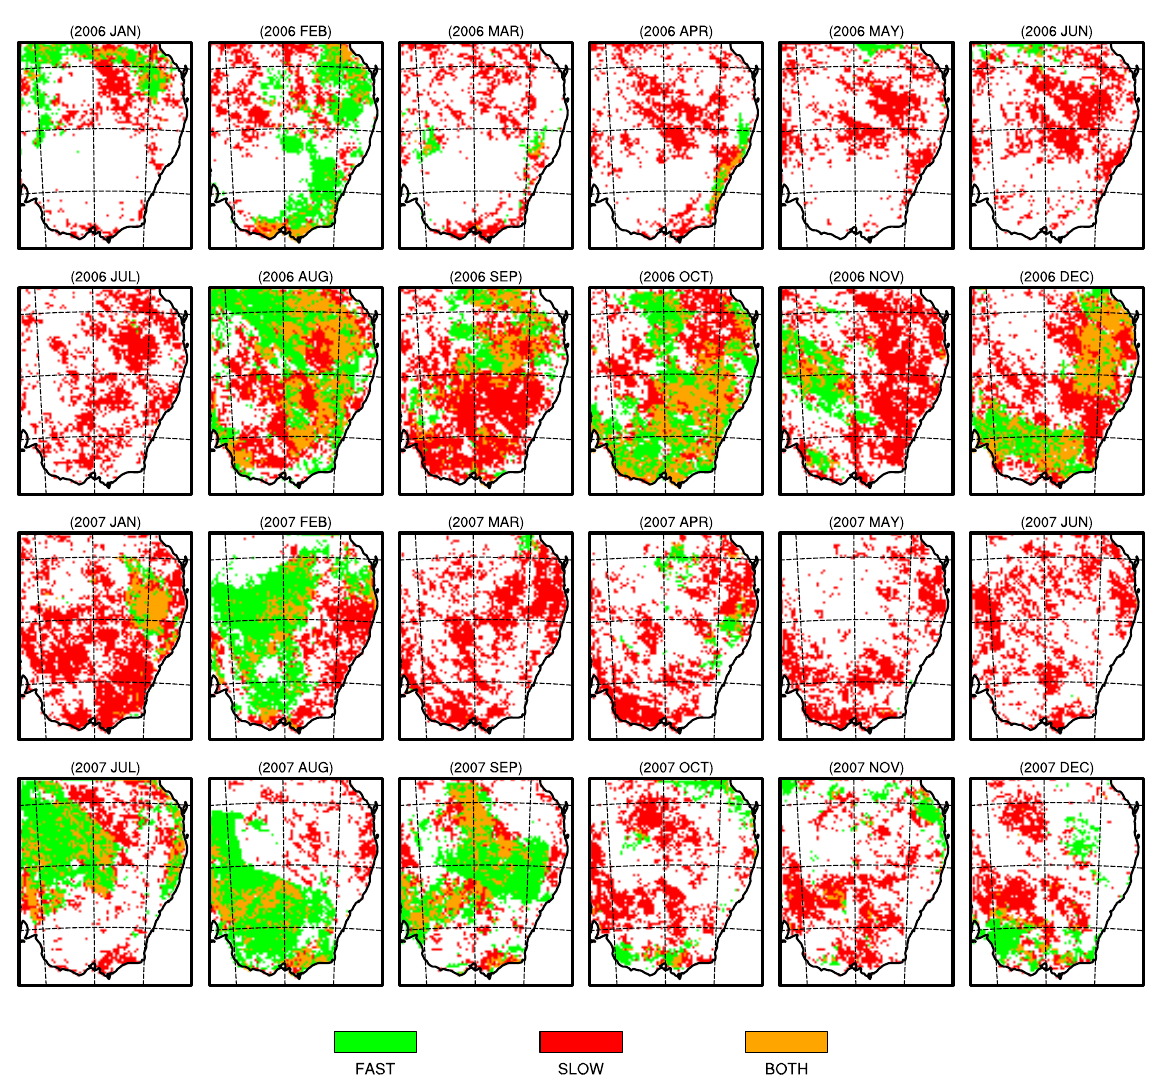
Figure 14. Distribution of the physical (fast) and biological (slow) mechanisms that exist in monthly and annual variations in the WRF_BOTH simulation in 2006 and